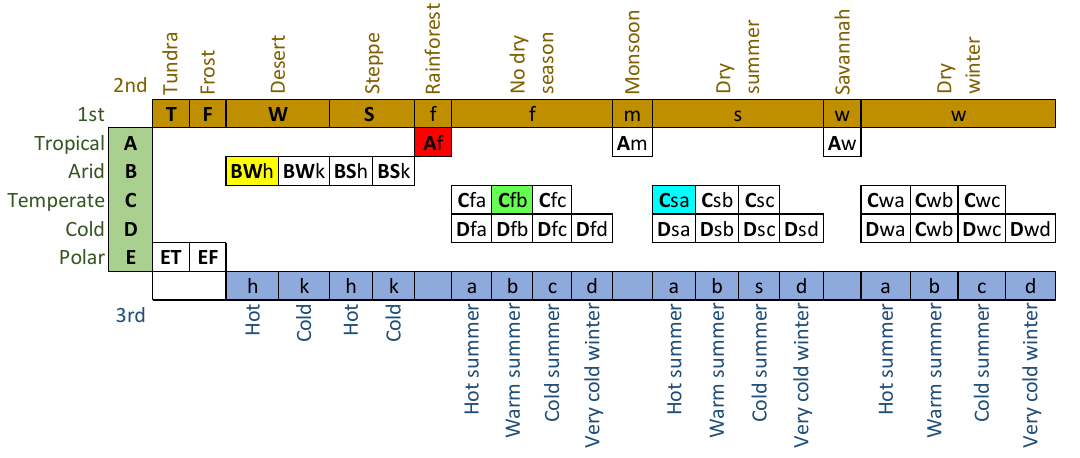
Figure 2. Thirty climatic subclasses according to Köppen–Geiger [45] and updated by [46].